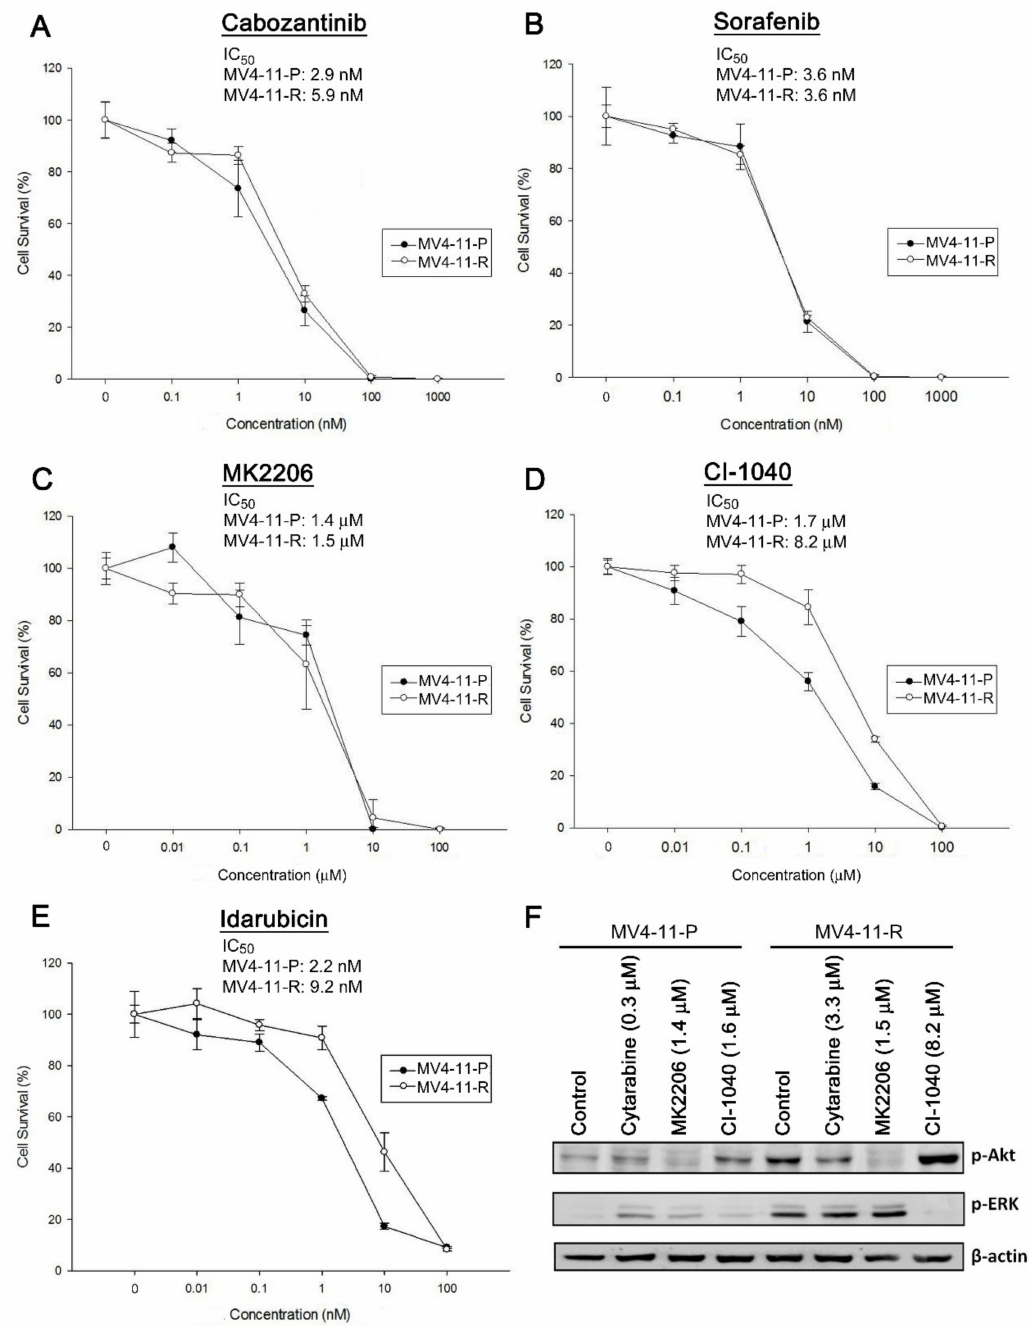
Figure 6. ( A – E ) Cytotoxicity curves and IC 50 values of anti-cancer drugs for MV4-11-P and MV4-11-R were evaluated by MTS assays. Data are representative of at least two independent experiments each performed in triplicate. Cells were drug-treated for 72 h before performing the MTS assay. ( F ) Phosphorylation of Akt and ERK in response to drug treatment in MV4-11-P and MV4-11-R was detected by Western blot analysis. Cells were treated with cytarabine, MK2206, or CI-1040 for 6 h before collection of cell lysates. DMSO (0.01%) served as a control. Representative Western blots of two independent experiments with similar results were